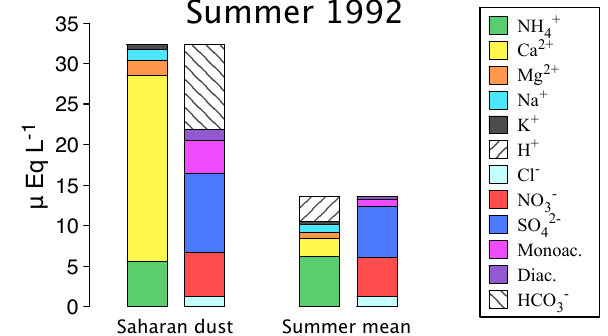
Fig. 3. Ionic content of CDK snow layers deposited during summer 1992. Left: a snow layer containing Saharan dust. Right: average over 1992 summer layers adjacent to the dust layer. Abbreviations Monoac. and Diac. stand for C 1 –C 3 monocarboxylates and C 2 –C 5 dicarboxylates, respectively (see Eqs. 2 and 3 in Sect.